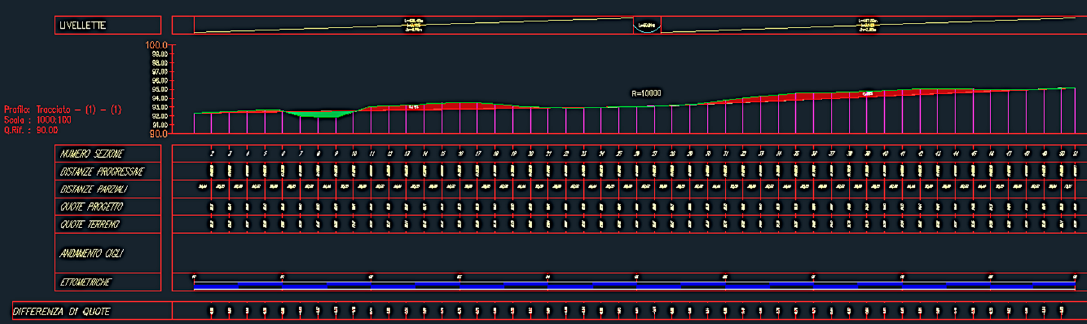
Figure 8. Top view of the road modelon the Digital Terrain ModelDTM.